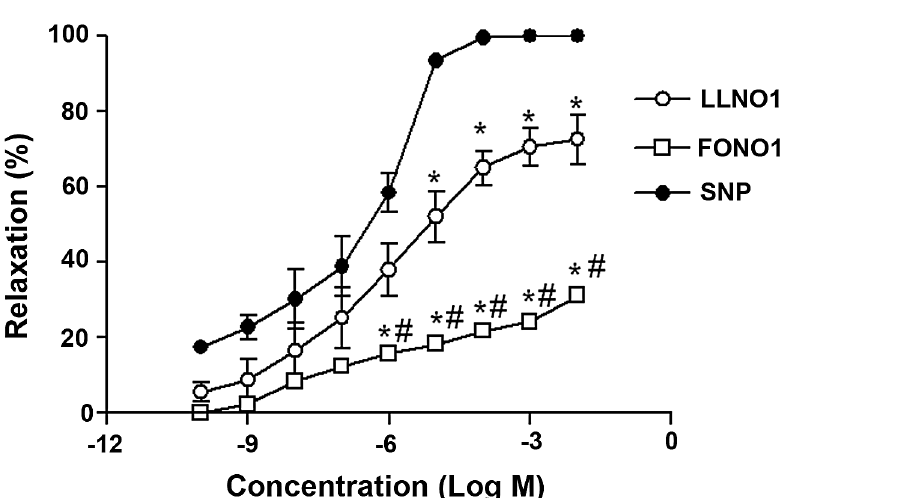
Figure 1 – Effect of LLNO1, FONO1 and sodium nitroprusside (SNP) upon rabbit corpus cavernosum (RbCC) strips. The RbCC strips were precontracted with 1 µ M phenylephrine and relaxation concentration/response curves (concentrations graded from 10 -12 to 10 -3 M) were plotted. Findings are expressed as average ± standard error, based on six experiments. * p < 0.05 vs. SNP (ANOVA followed by the Tukey-Kramer test). # p < 0.05 vs. LLNO1 (ANOVA followed by the Tukey-Kramer test).